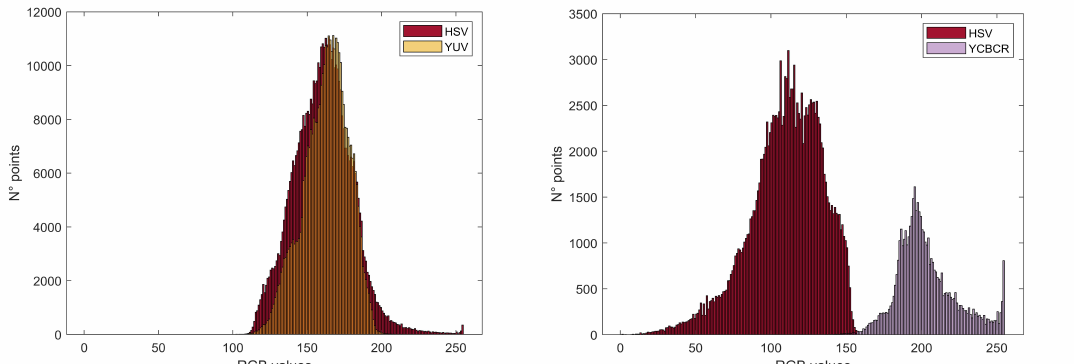
Figure 6 . Clusters’ histogram overlapping (left: 75% overlapping; right: 0.12 % overlapping).